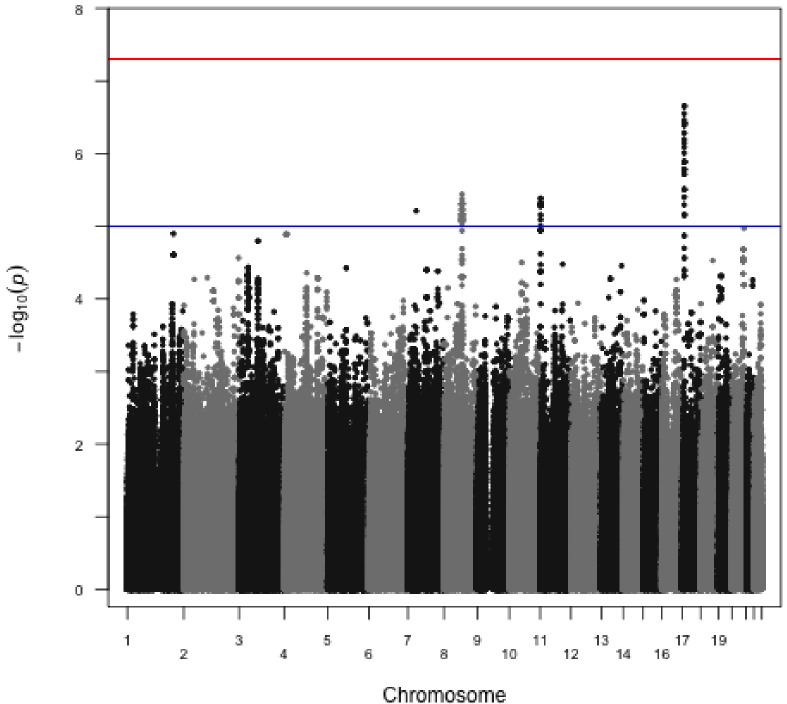
Manhattan plot showing post-imputation genome-wide association results.Data for chromosomes X and Y was removed prior to imputation. Analysis highlighted three main chromosomal regions of association. The blue line denotes a p-value cutoff of 10−5 (suggestive significance) and the red line is at p-value = 5x10-8 (genome-wide significance).